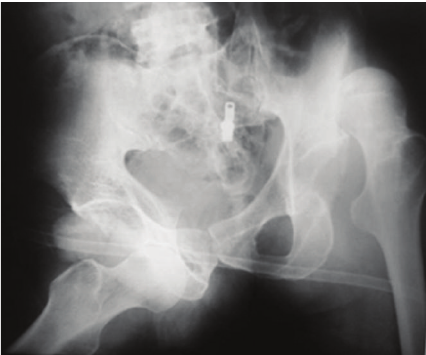
Figure 2: Radiograph showing anterior dislocation of right hip and posterior dislocation of left hip joint, without any associated fracture.